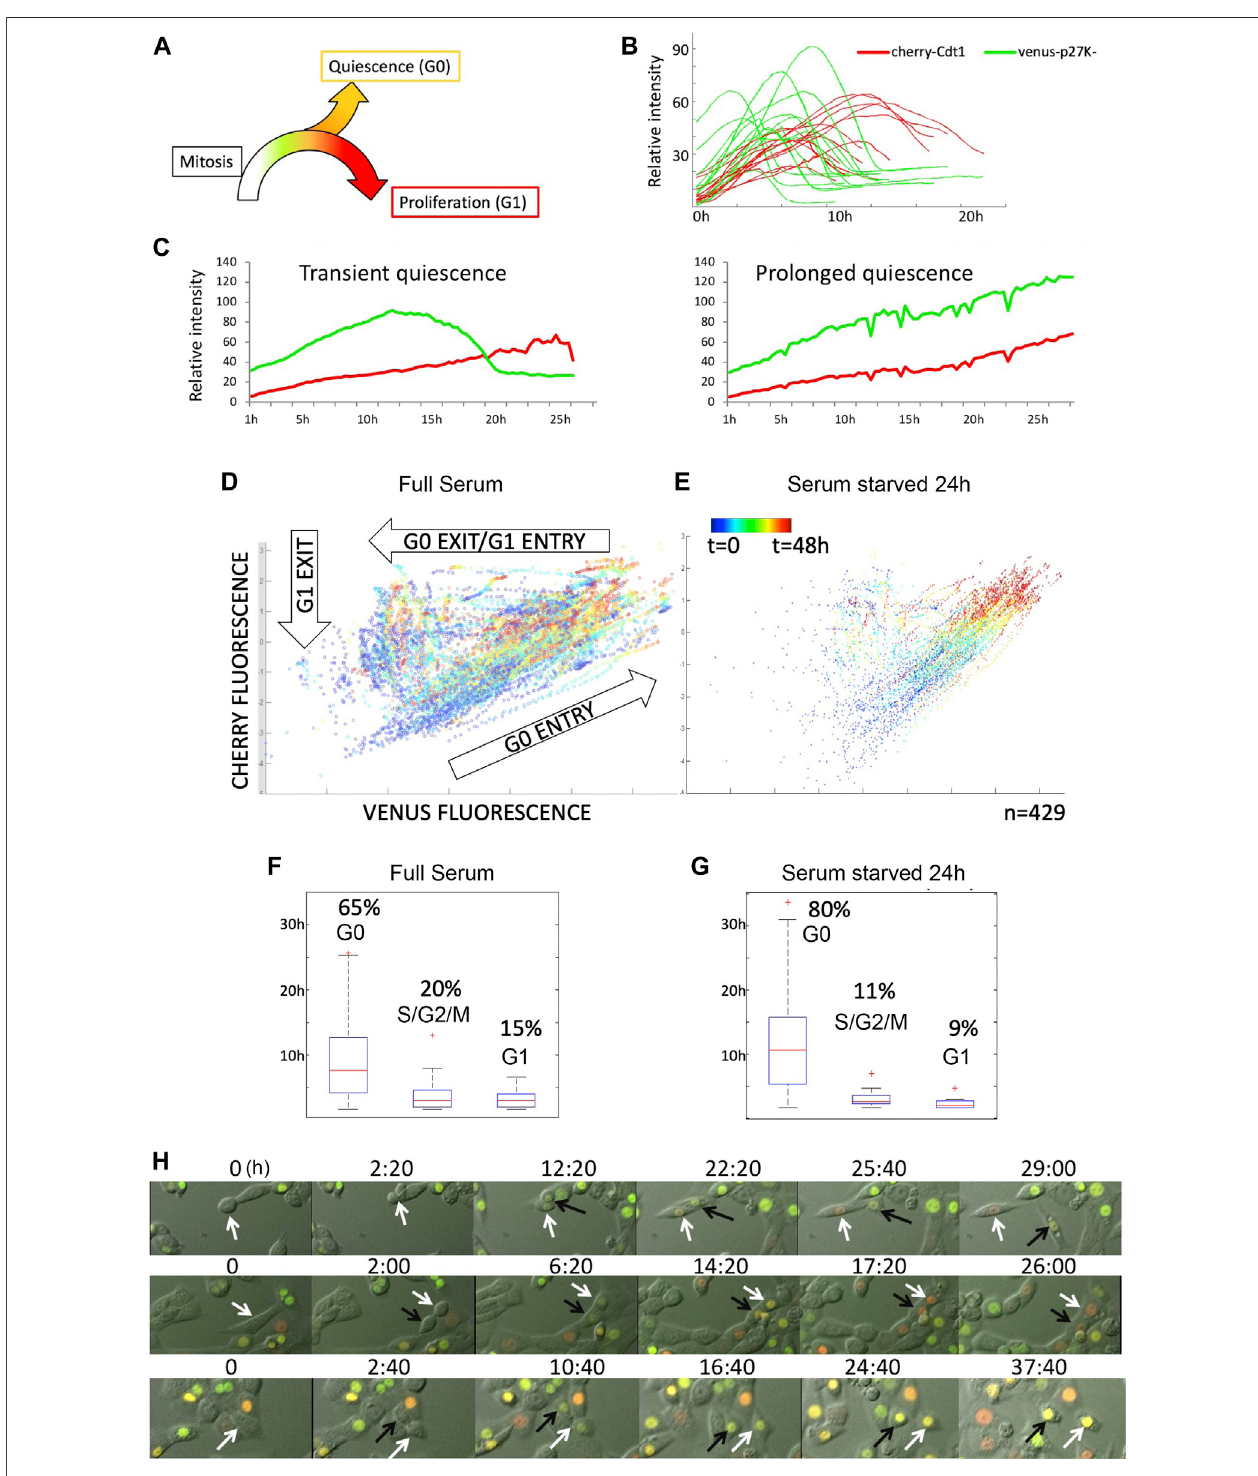
FIGURE 1 | The G0 sensor, mVenus-p27K-, can be used to monitor spontaneous quiescence and asynchronous proliferation-quiescence decisions in untransformed cells. (A) The proliferation-quiescence decision as monitored with the G0 sensor, mVenus-p27K- (G0-Venus) and G1 sensor hCdt1 (30 – 120) -Cherry (G1- Cherry). For NIH/3T3 cells, on average, 2 – 4 h after cytokinesis, G0-Venus expression begins increasing, followed approximately 3 – 4 h later by G1-Cherry expression. For cells entering G1, the Venus/Cherry double-positive phase lasts 5 – 10 h. For quanti fi cation purposes we de fi ne a Venus/Cherry double-positive phase prolonged beyond 14 h as spontaneous G0. (B) Example traces ofG0-Venus/G1-Cherry reporter dynamics in cells entering the cell cycle.0 h isrelativetime, aligned to